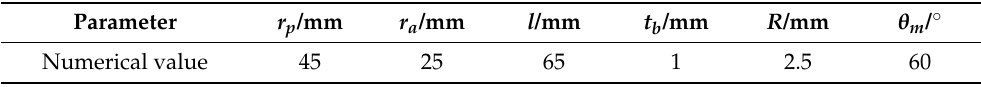
Table 1. Dimension parameters of the